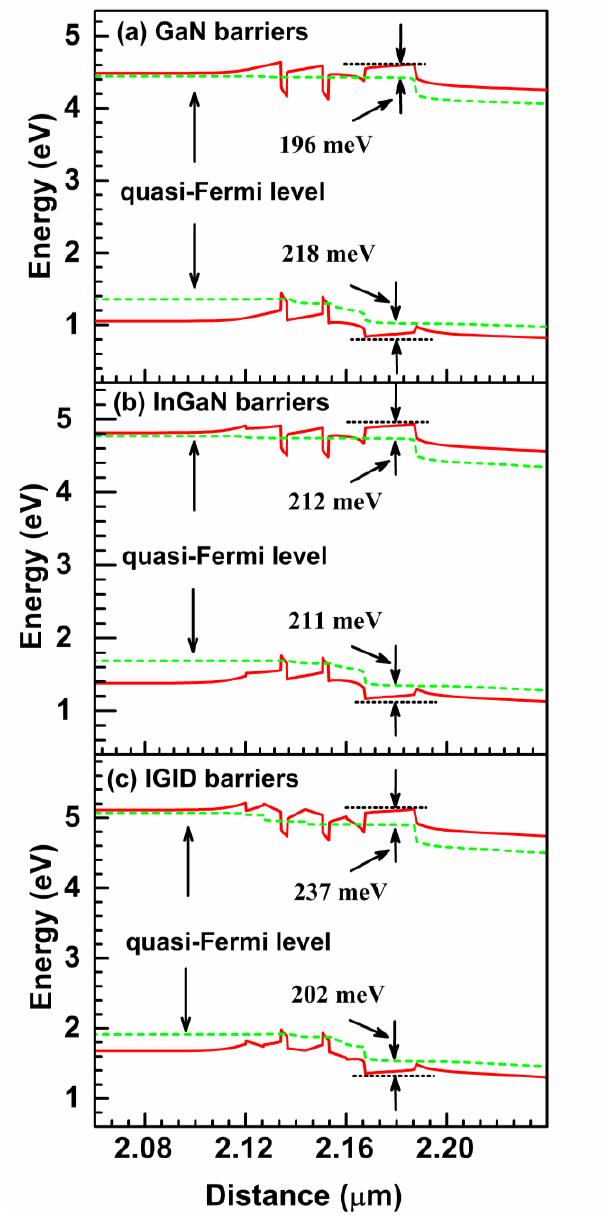
Figure 3. Energy band diagrams for the LDs with the ( a ) GaN, ( b ) InGaN, and ( c ) IGID barriers at 120 mA.